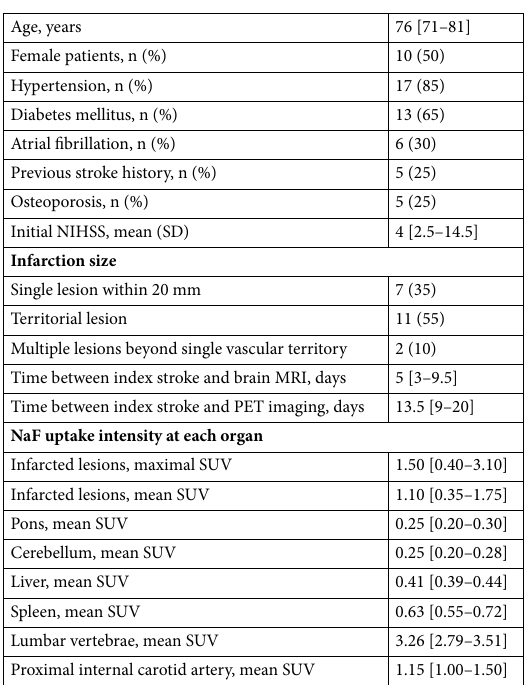
Table 1. Demographic, clinical and imaging variables of the included patients. NIHSS stands for National Institute of Health Stroke Scale; SD, standard deviation; PET, positron emission tomography; NaF, 18 F-sodium fluoride; SUV, standardized uptake value. Variables are displayed as the number of patients (percentage) or median [25th–75th percentile] as